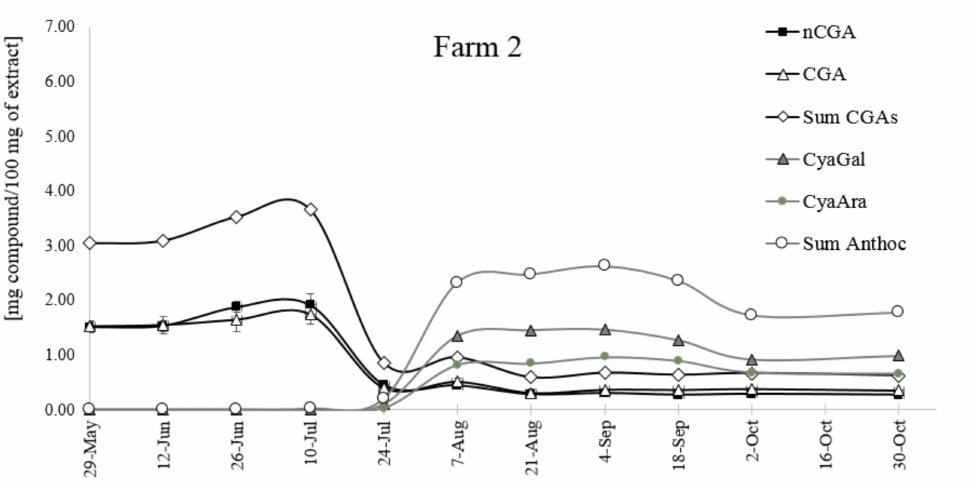
Figure 9. The changes of the CGA and anthocyanin contents from May to October in the fruit from the higher altitude location (farm